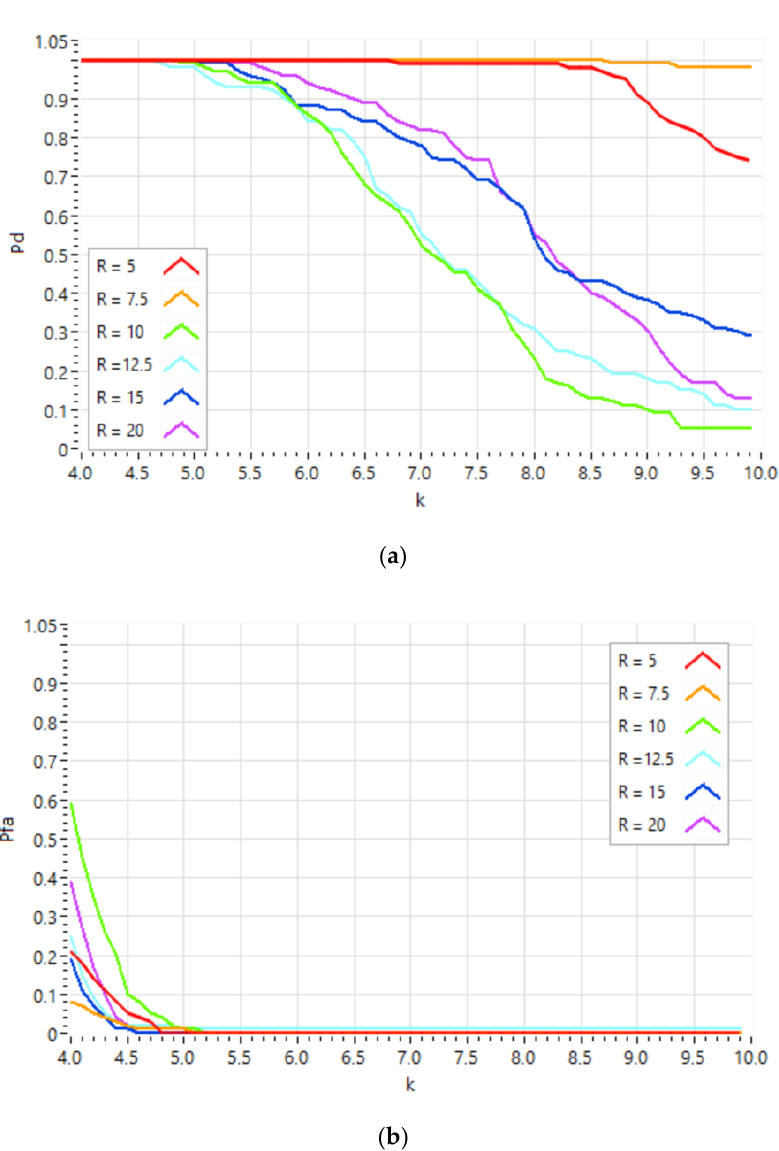
Figure 8. ( a ) Detection Probability and ( b ) False Alarm Probability, for the test